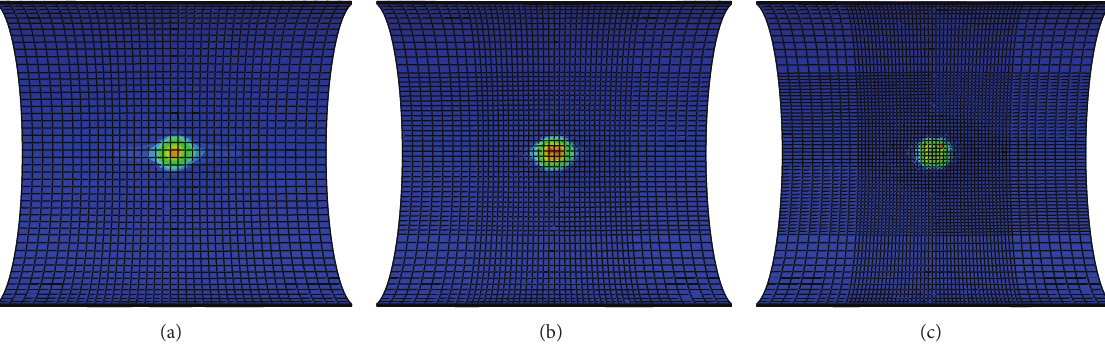
Figure 9: An illustration of the introduction of nonlocal damage effects in the BCJ model to reduce the mesh size effects in the FE simulations of hazmat tank car. The contour plots of the damage on the inner face of the tank are shown for three different meshes at the same time as in Figure 7: coarse (a), medium (b), and fine (c). Note the quasisimilarity of the damage pattern size for the three meshes.